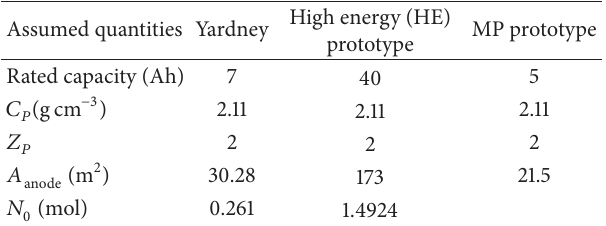
Table 2: List of assumed quantities used in the calculations.